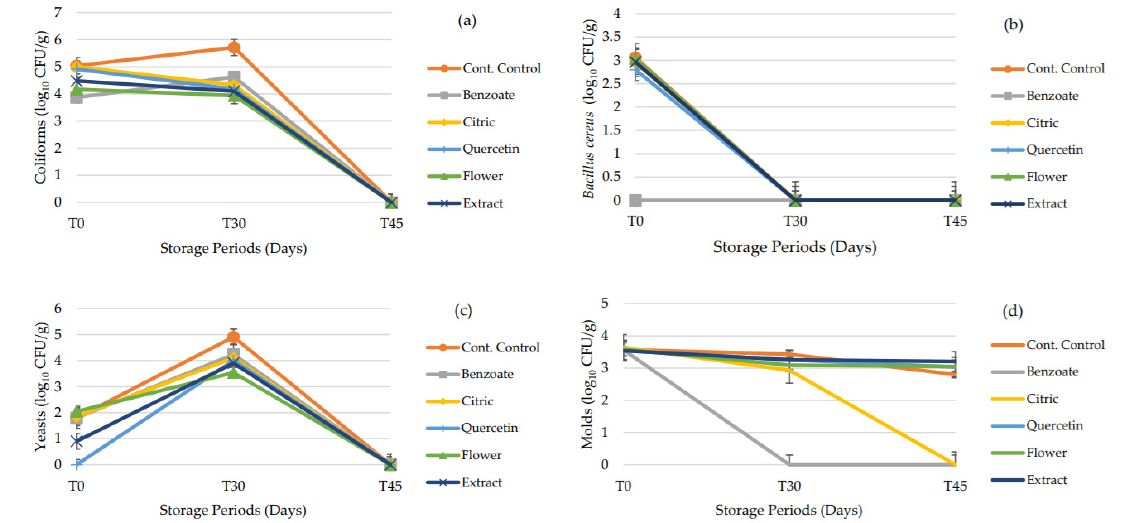
Figure 2. Microbial development along the 45 days of storage time for ( a ) coliforms, ( b ) Bacillus cereus , ( c ) yeasts, and ( d ) molds.